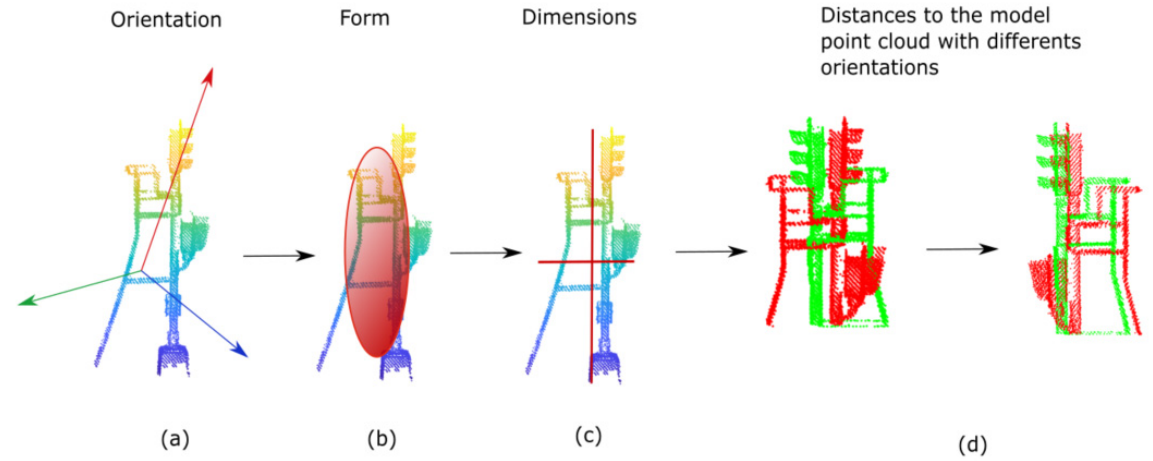
Figure 11. Signage elements classification process: ( a ) checking the orientation; ( b ) checking the form; ( c ) checking its dimensions; ( d ) checking the distance to the point cloud of the model.